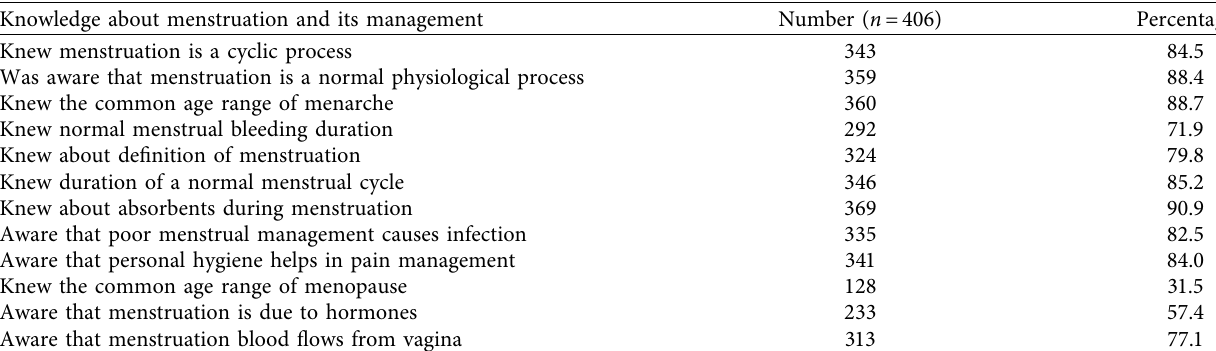
Table 2: Adolescent school girls’ knowledge about menstruation and its management.